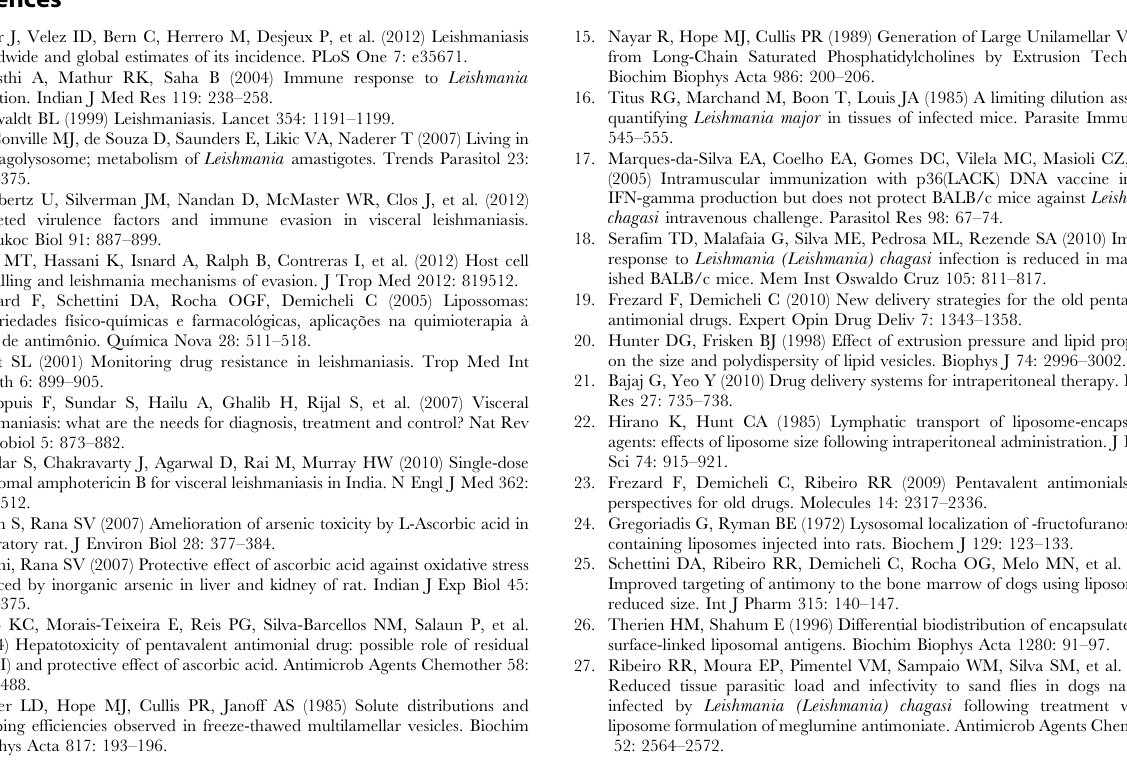
Figure S4. Ex vivo immunophenotyping of macrophages from L. infantum infected mice submitted to treatment regimens. (PBS: A-D) phosphate-buffered, (Sb: E-G) saline trivalent antimony, (Empty Lipo: H-J) empty liposomes, (Sb Lipo: are represented as mean 6 SD whereas for (X) as median 6 interquartile range of two independent experiments. No statisti- cally significant differences were